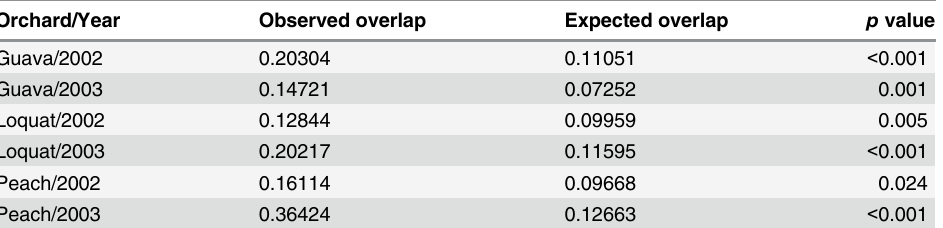
Table 2. Observed and expected temporal niche overlap (Pianka ’ s index) and the one-tailed p -value based on 1000 randomizations for fruit fly assemblages sampled in three orchard types over two years.